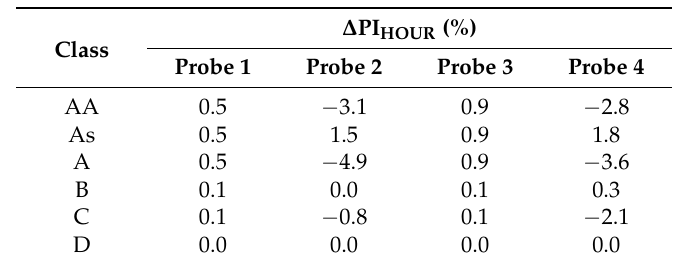
Table 10. Differences between reference PI MINUTE values in Table 2 and PI obtained with the dataset associated to extractions every hour. Performance Index (PI) is calculated as the percentage of time for which the combination of T and RH data fits into the specifications of each ASHRAE climate class. The differences ∆ PI HOUR are calculated as (PI HOUR – PI MINUTE